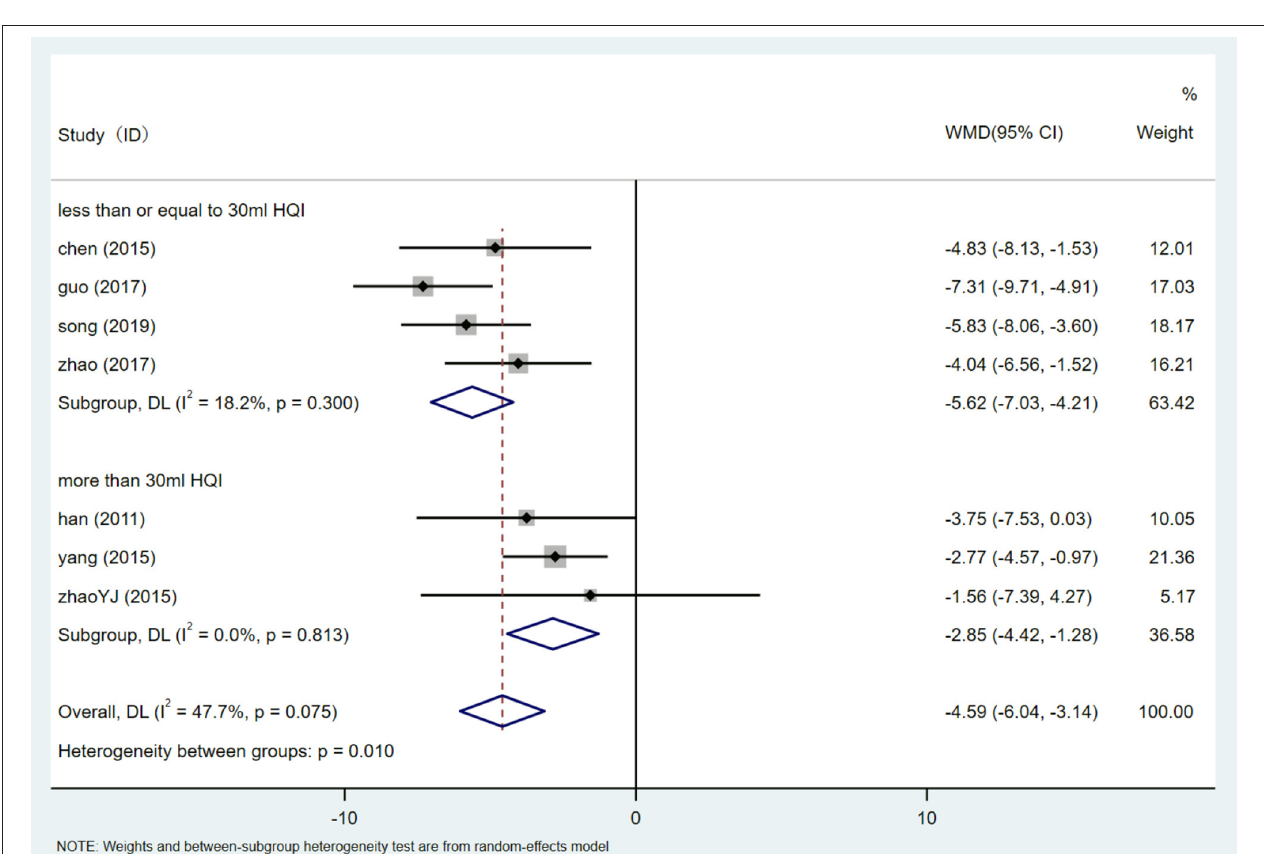
FIGURE 12 | Subgroups analysis of